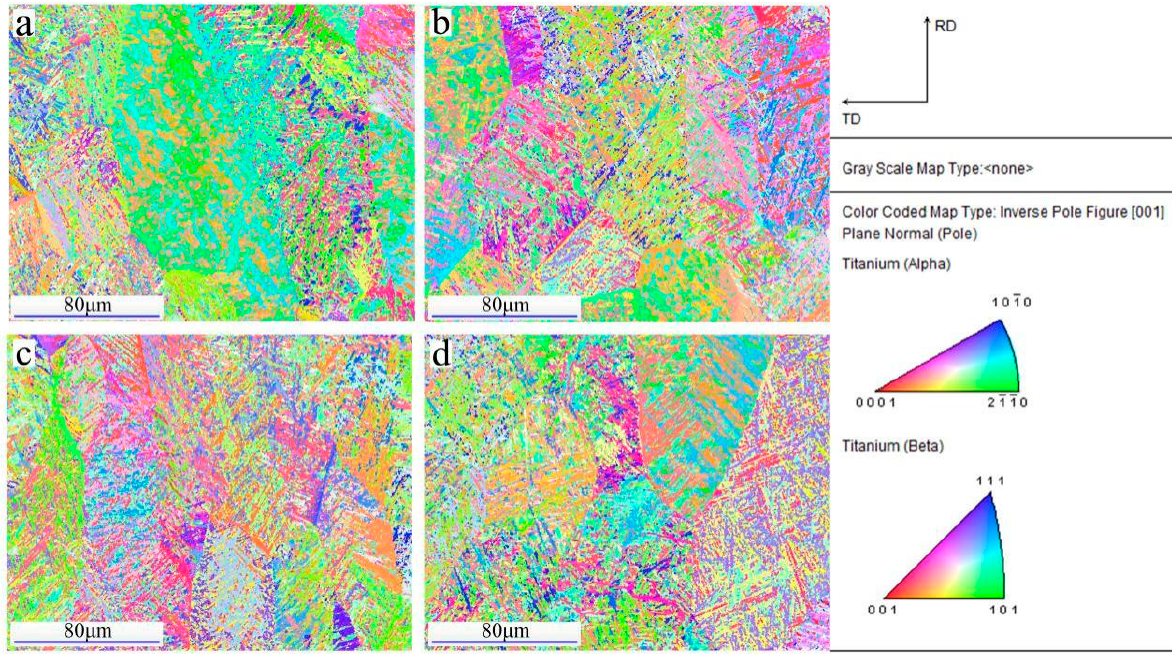
Figure 7. Grain morphology and crystal orientation of titanium alloy DED-AAM component with the wire feeding speed of 7 m/min: ( a ) I M = 0 A, ( b ) I M = 1 A, ( c ) I M = 2 A, ( d ) I M = 3